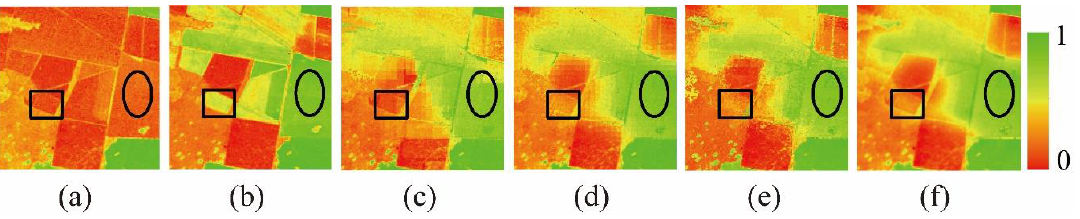
Figure 10. Visual comparison of inset map in cultivated land area. ( a , b ). Original Landsat_NDVI inset map on 5 July and 22 August 2004; ( c – f ). Predicted Landsat_NDVI inset map by ESTARFM, NDVI-LMGM, FSDAF, and NDVI_FMHC. Table 3. Accuracy comparison of four fusion methods in cultivated land area.